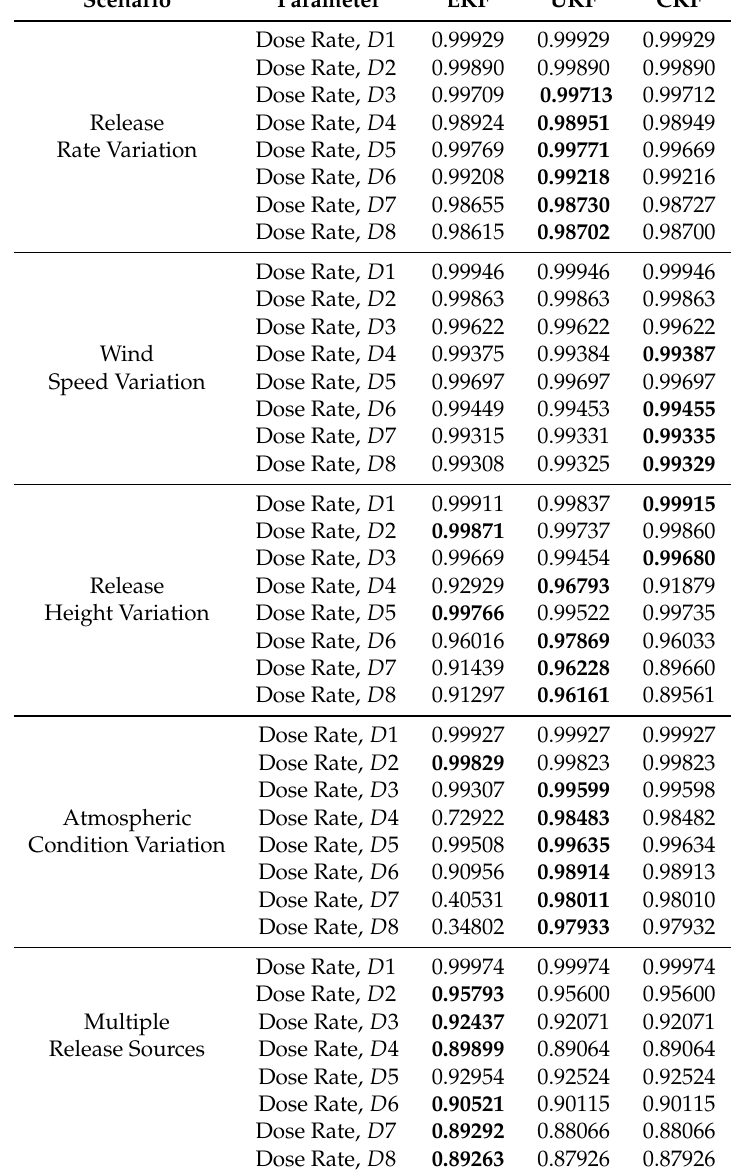
Table 5. Sample correlation coefficients between true and estimated dose rates for EKF, UKF, and